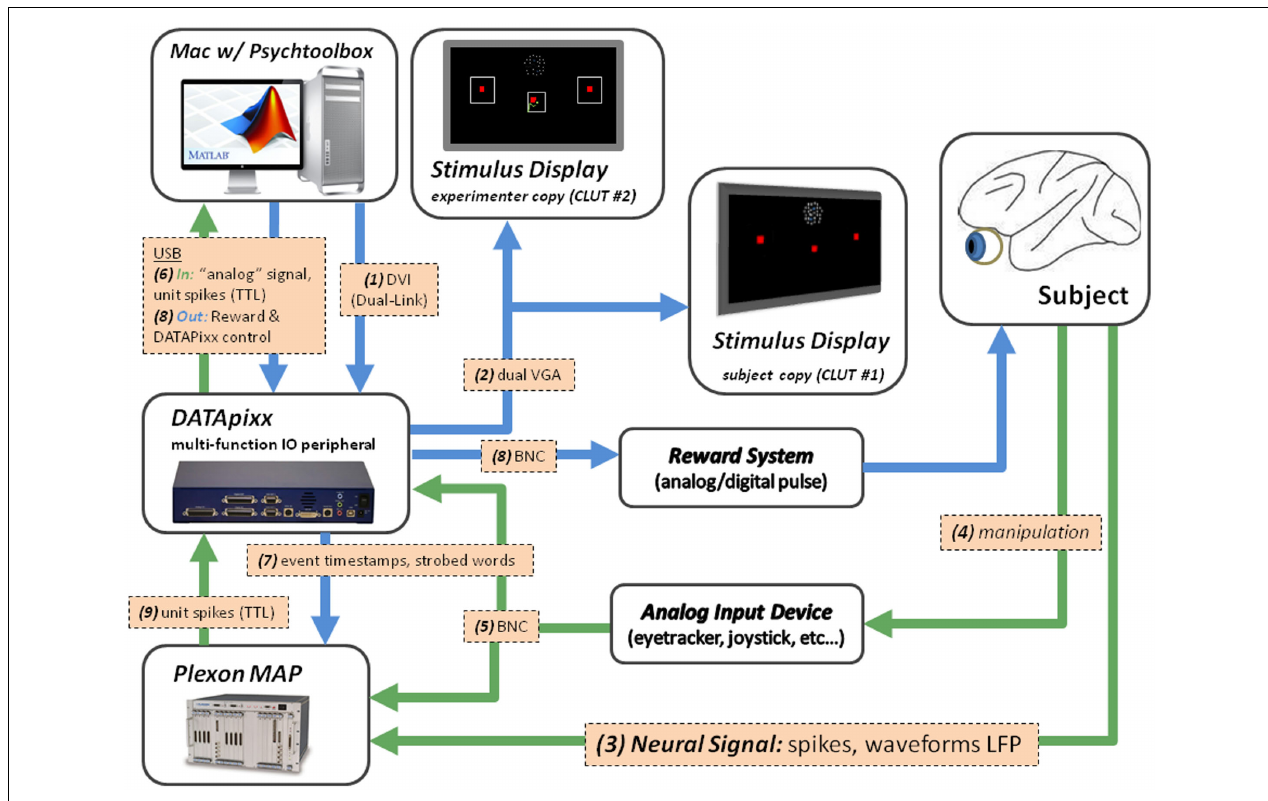
Plexon MAP. (4)The subject also manipulates the input device. (5) Redundant analog signals are sent both to the Plexon device and